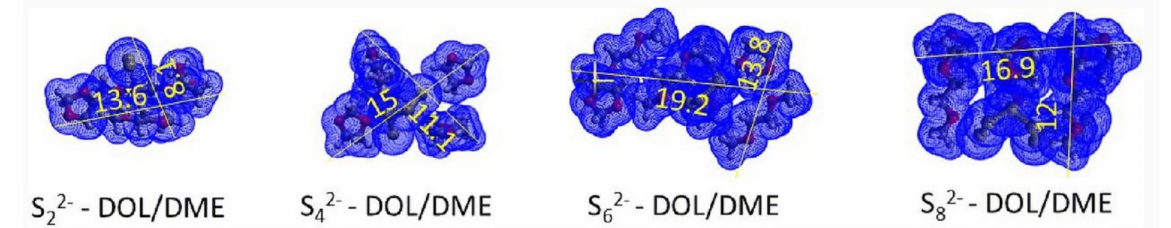
Figure 2. 3-D molecular models of solvated intermediate polysulfide anions including Van Der Waals surfaces. Electrolyte solution is LiTFSI in DOL/DME with dimensions measured in angstroms [89]. Produced by Babar, S. and Lekakou, C., licensed under CC BY